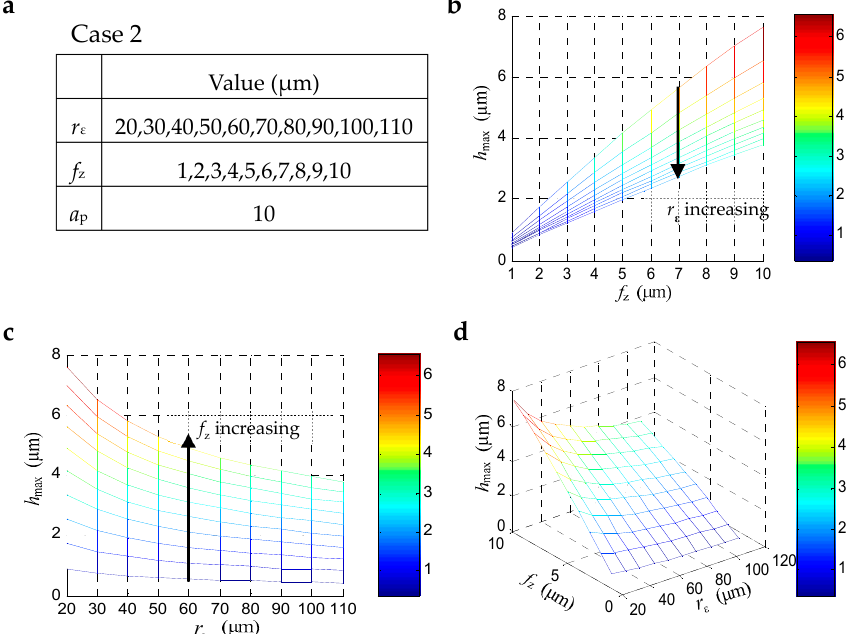
Figure 4. The maximum uncut chip thickness h max changes with f z and r ε . : ( a ) parameters setting, ( b ) 2D-view from the perspective of f z , ( c ) 2D-view from the perspective of r ε , ( d ) 3D-view from both f z and r ε .